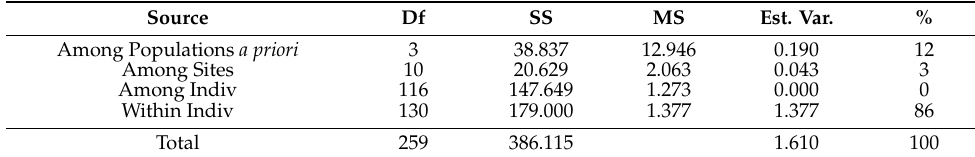
Table A4. Summary Analysis of molecular variance (AMOVA), percentage of variation among genetic groups identified a priori with Geneland, between sites in the same group, and between individuals of the Campylorhynchus yucatanicus in the northern Yucatan Peninsula, Mexico.